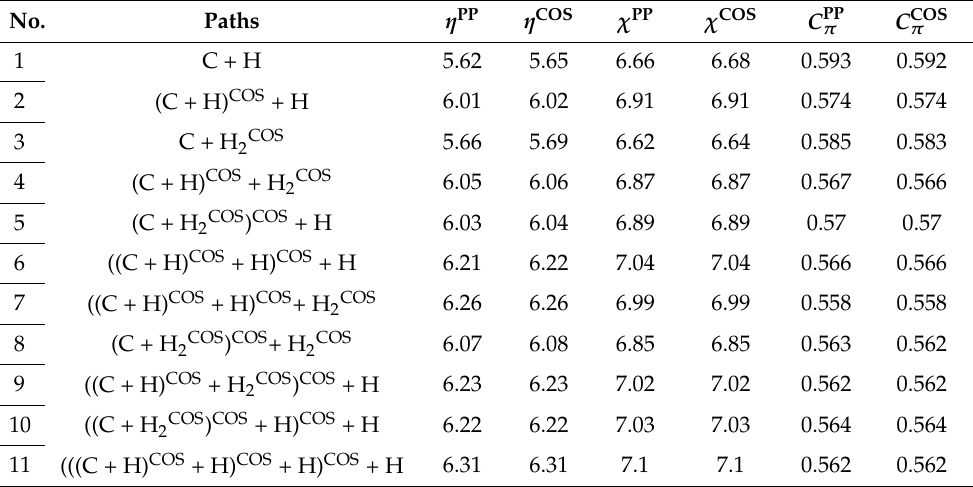
Table 7. The same information as in Table 6 for the target CH 4 molecule.